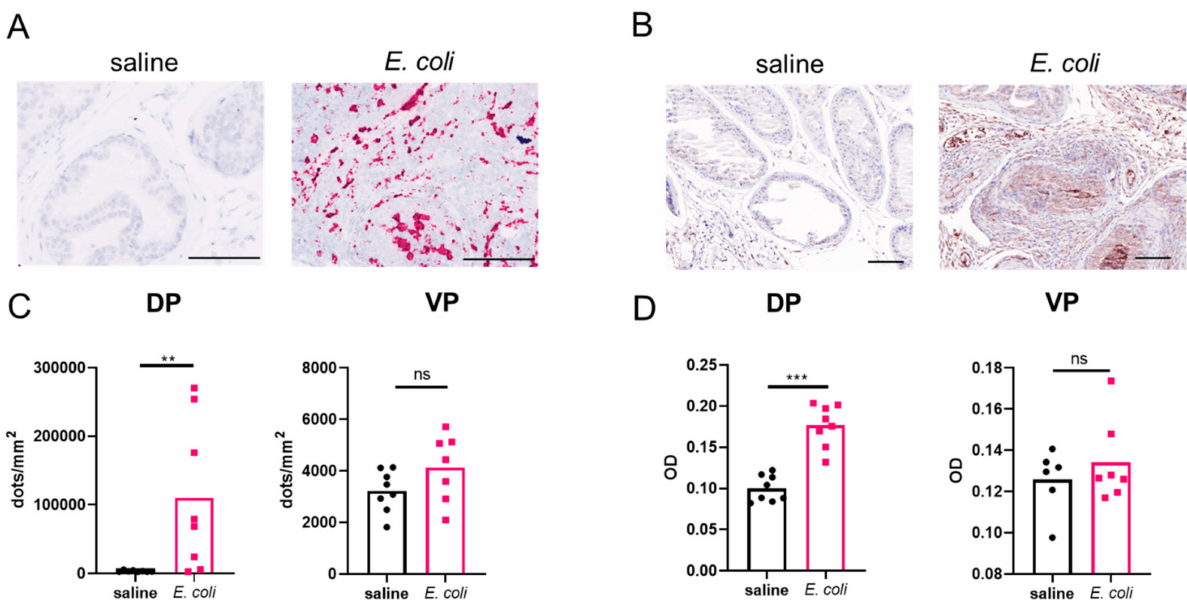
Figure 1. Spp1 gene expression and osteopontin (OPN) protein levels are induced in bacterial prostatic inflammation. Both mRNA and protein expression significantly increase in response to bacterial instillation in the dorsal (DP) but not in the ventral prostate (VP). Panel ( A , C ) show RNAscope staining and signal quantification, respectively. Images were captured at 40 × magnification. Panel ( B , D ) show immunohistochemistry staining and optical density, respectively (OD). RNAscope signal was normalized to tissue area, and OPN OD was quantified by inForm software. Images were captured at 20 × magnification. Ns: not significant. Scale represents 100 µ m. ** p < 0.01; *** p <